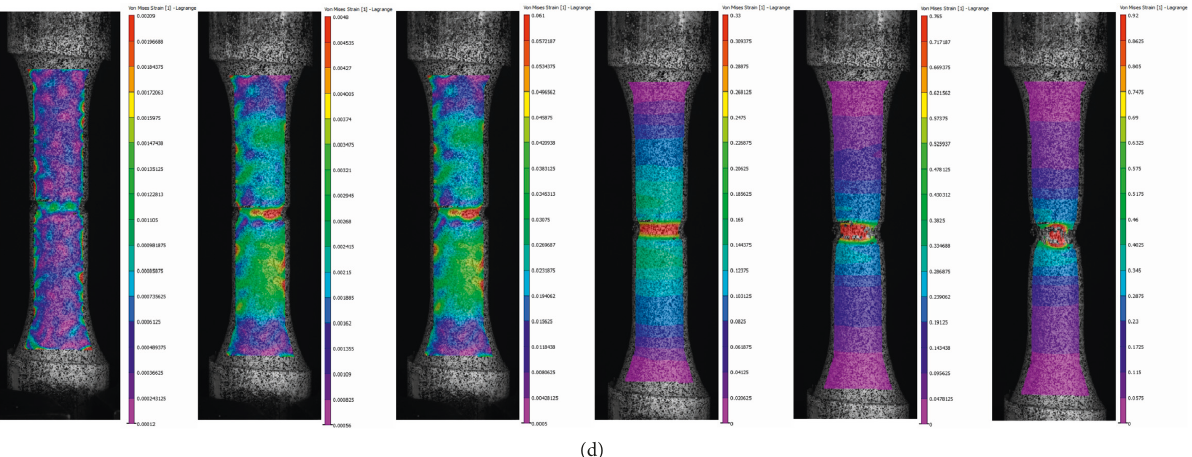
Figure 8: The stress nephogram distribution of BMZ specimens. (a) B-6-SB. (b) B-6-B. (c) B2-6-B. (d) B0.5-6-B.